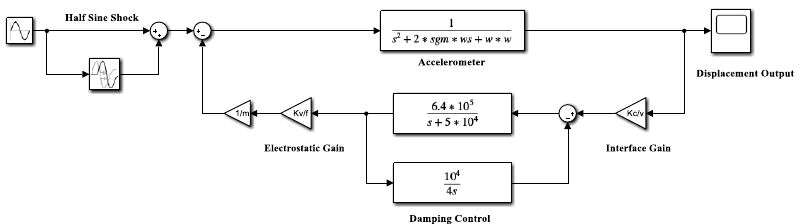
Figure 8. Open-loop Bode diagram of the damping control circuit.